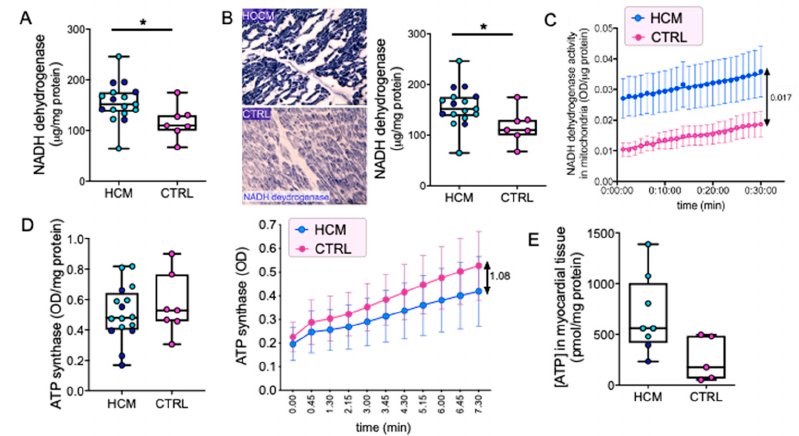
Figure 1. OXPHOS complexes I and V and ATP synthesis. Quantification of NADH dehydrogenase protein amount in myocardial tissue from 17 HCM and seven control (CTRL) samples is shown. ( A) Representative images of NADH dehydrogenase histochemistry on myocardial cryosections are shown ( B, left panels). Blue formazan intensity indicates NADH enzyme activity in cryosections. Semiquantitative evaluation of formazan signal optical density in 10 HCM and six CTRL chosen randomly is presented ( B, right graph). Kinetics of Complex I activity (i.e., oxidized NADH) in tissue-isolated mitochondria ( C) are plotted . Mean optical density values/group ±SEM (17 HCM and 7 CTRL samples) are shown for absorbance read every 1 min. The double arrow indicates the difference between the parallel curves at the end of the measure. Quantitative evaluations of ATP synthase amount ( D , left graph) and kinetics ( D , right graph) are shown (16 HCM, seven CTRL, three replicates/sample). In ( D, right graph), mean optical density values/group ±SEM are shown for absorbance read every 45 seconds. Double arrow indicates the difference between the fit curves for HCM and CTRL at the end of the measure. Quantification of ATP amount in a subset of myocardial tissues (eight HCM and five CTRL samples) is plotted ( E ). Unpaired t-test is applied. Data in ( A) left, ( B , D, left ) and ( E ) are presented in boxes (min to max) and dots indicate single sample values (mean values from three replicates). Dark blue dots indicate HCM patients with mutation, light blue dots those without. Significant differences are shown as * p < 0.05, ** p < 0.01.